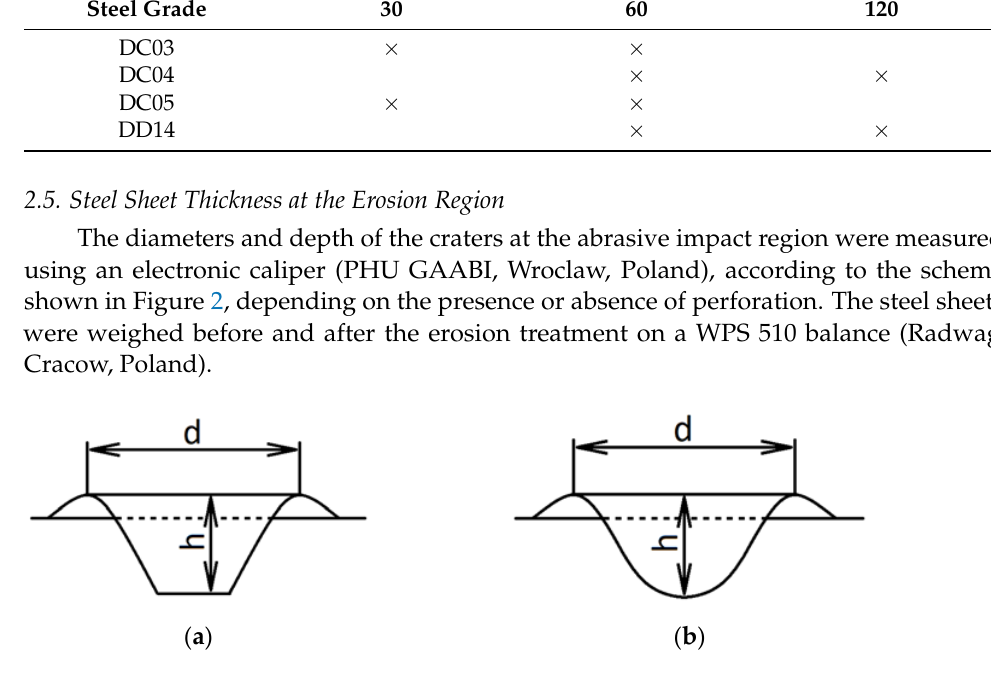
Figure 2. The method of performing deformation measurements after the steel sheet erosion test: ( a ) With perforation; ( b ) without perforation. d—diameter and h—height.